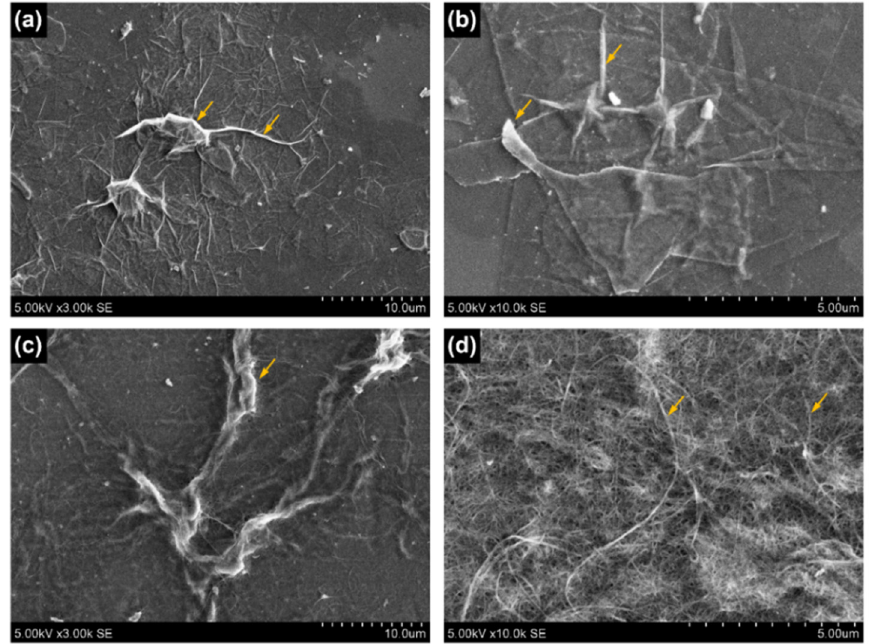
Figure 1. Scanning electron microscopy images of: ( a ) 3-layer MXene coating ( b ) magnified region; ( c ) 5-layer PEDOT-CNT coating ( d ) magnified region (yellow arrows clarified in the text).